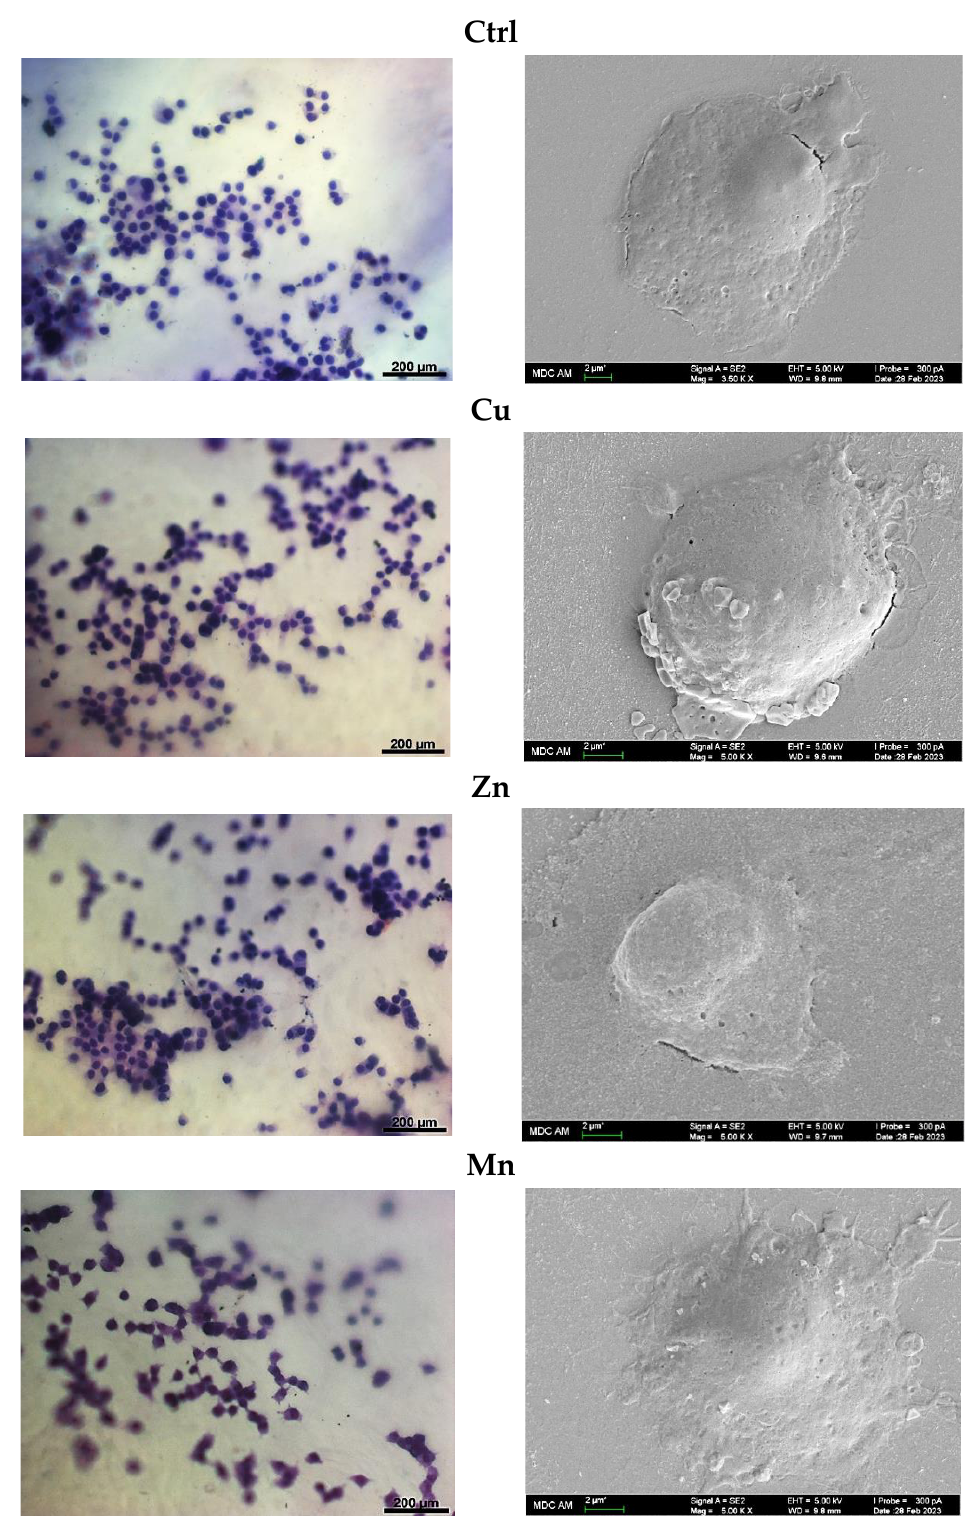
Figure 8. Bright - field microscopy images ( left panel ) and scanning electron microscopy images Figure 8. Bright-field microscopy images ( left panel ) and scanning electron microscopy images ( right panel ) of fixed PC - 12 cells at 24 h post - seeding on TM - modified PA matrices. For bright - field ( right panel ) of fixed PC-12 cells at 24 h post-seeding on TM-modified PA matrices. For bright-field microscopy, the cells were stained with cresyl violet. microscopy, the cells were stained with cresyl